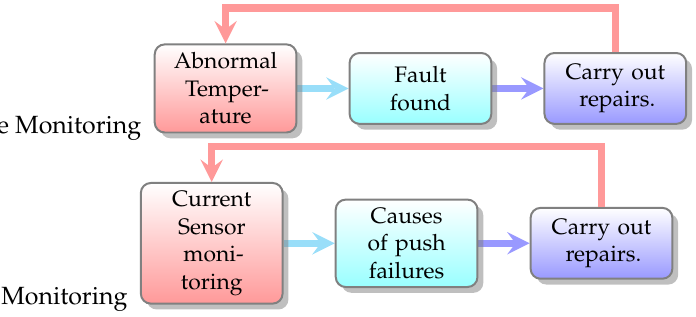
Figure 2. Cycle of Abnormal